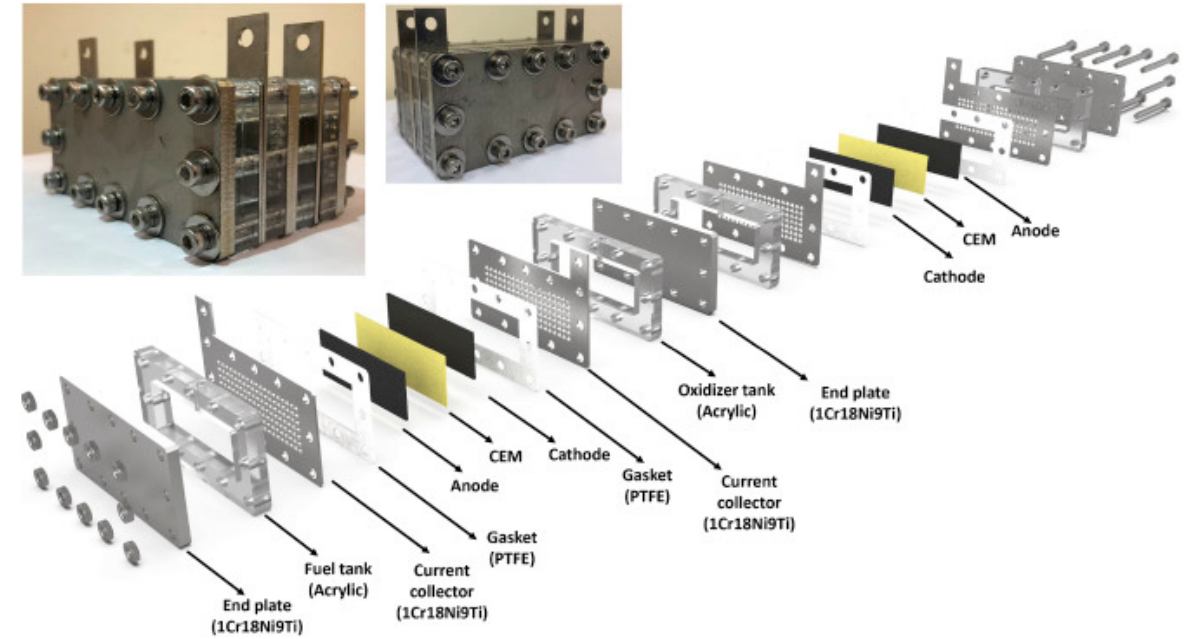
Figure 19. Schematic of the AA-based PS-DEGFC stack. Reproduced from [174] with permission from Elsevier 2019.